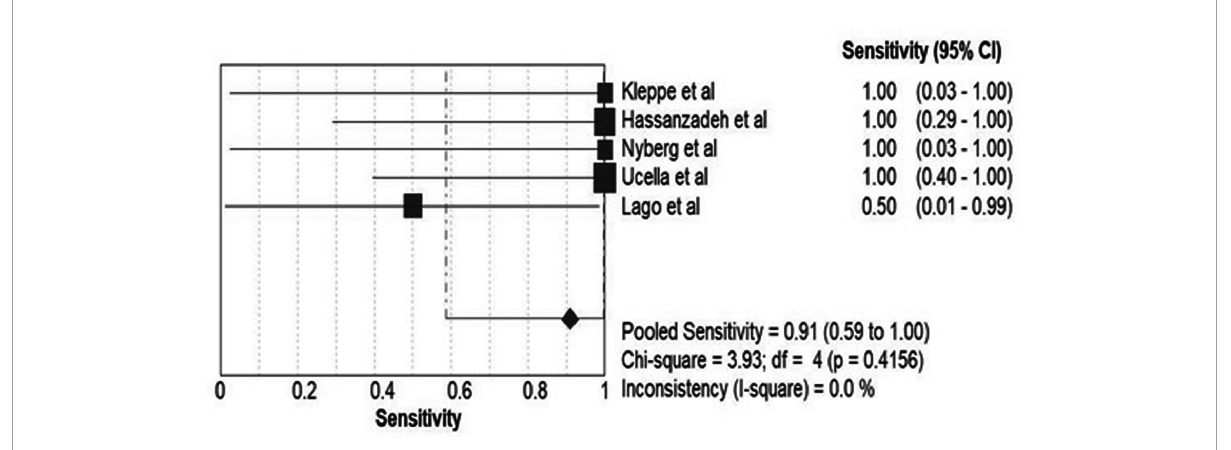
FIGURE5 Pooled sensitivity of the included studies for detection of involved